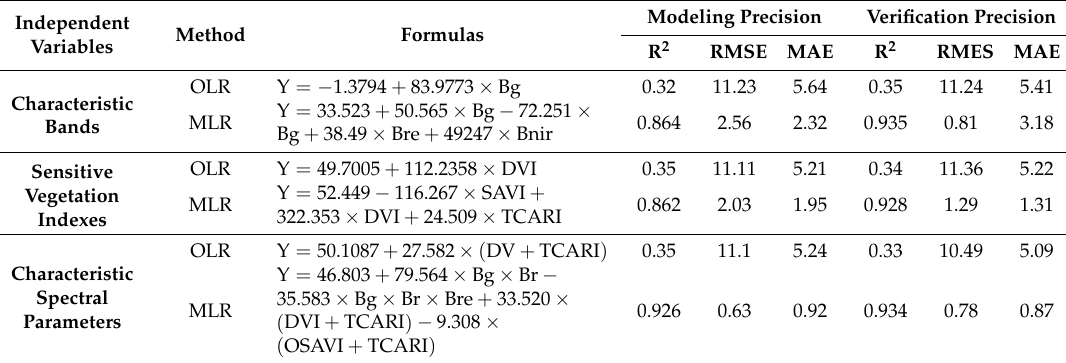
Table 7. Linear regression inversion models of SPAD based on UAV